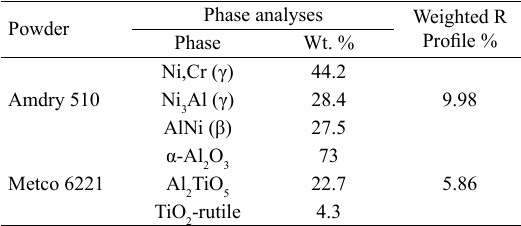
Table 4. Phase analysis of feedstock powders